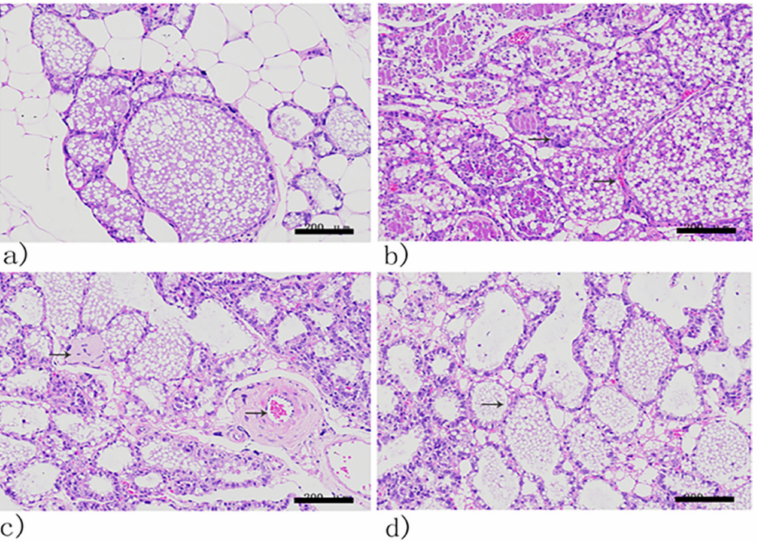
Figure 10. Histopathological sections of mammary glands after phage treatment. ( a ) Tissue sections of the mammary glands of the control group revealed no abnormal histopathological changes. ( b ) In the PBS-treatment group, the acinar epithelial cells were partially necrotic and apoptotic, with a large number of inflammatory cells infiltrating the acinar space and acini (as indicated by the arrows). ( c ) The mammary glands of the ceftiofur sodium-treated groups showed relatively fewer inflammatory cells infiltrating (as indicated by the arrows). ( d ) Mice treated with phages exhibited normal mammary glands. The cuboidal epithelial cells and acini were intact (as indicated by the arrow). Sections were stained with hematoxylin and eosin and photographed at 40 ×